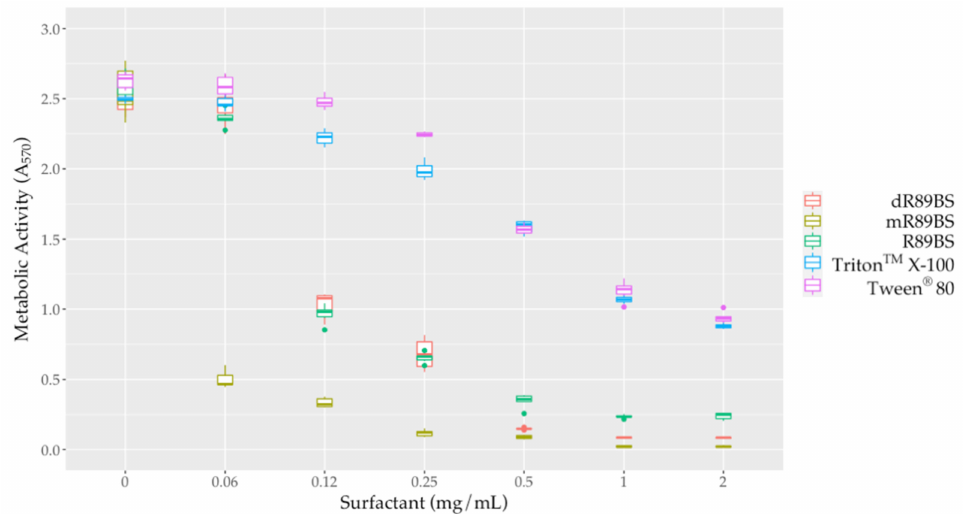
Figure 5. Metabolic activity of S. aureus ® 6538 TM biofilms after treatment with surfactants. To evaluate the dislodging effect of surfactants, pre-formed biofilms were co-incubated with increasing concentrations of the different samples for 24 h at 37 ◦